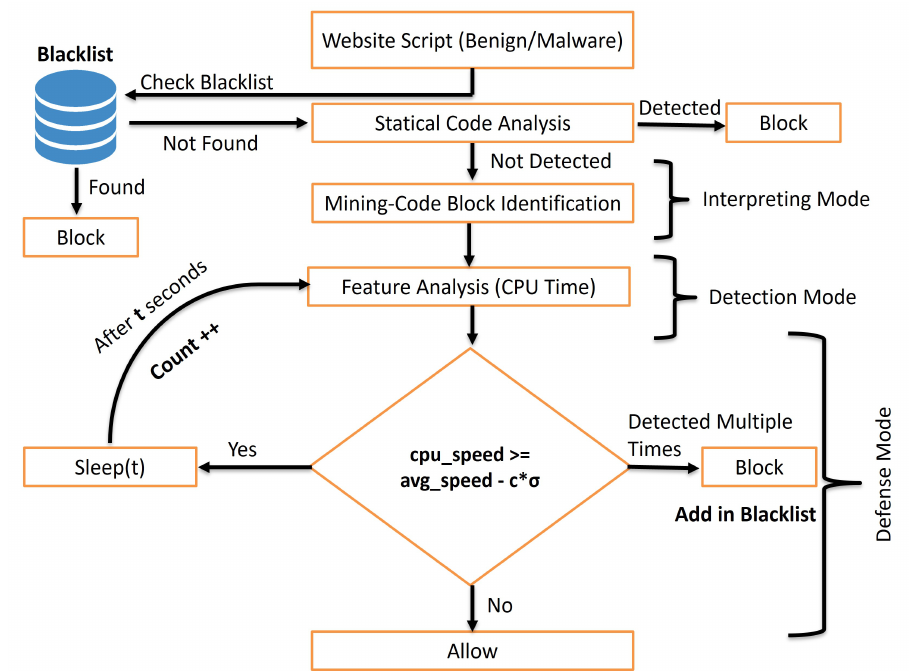
Figure 2. Architectural diagram of proposed approach.